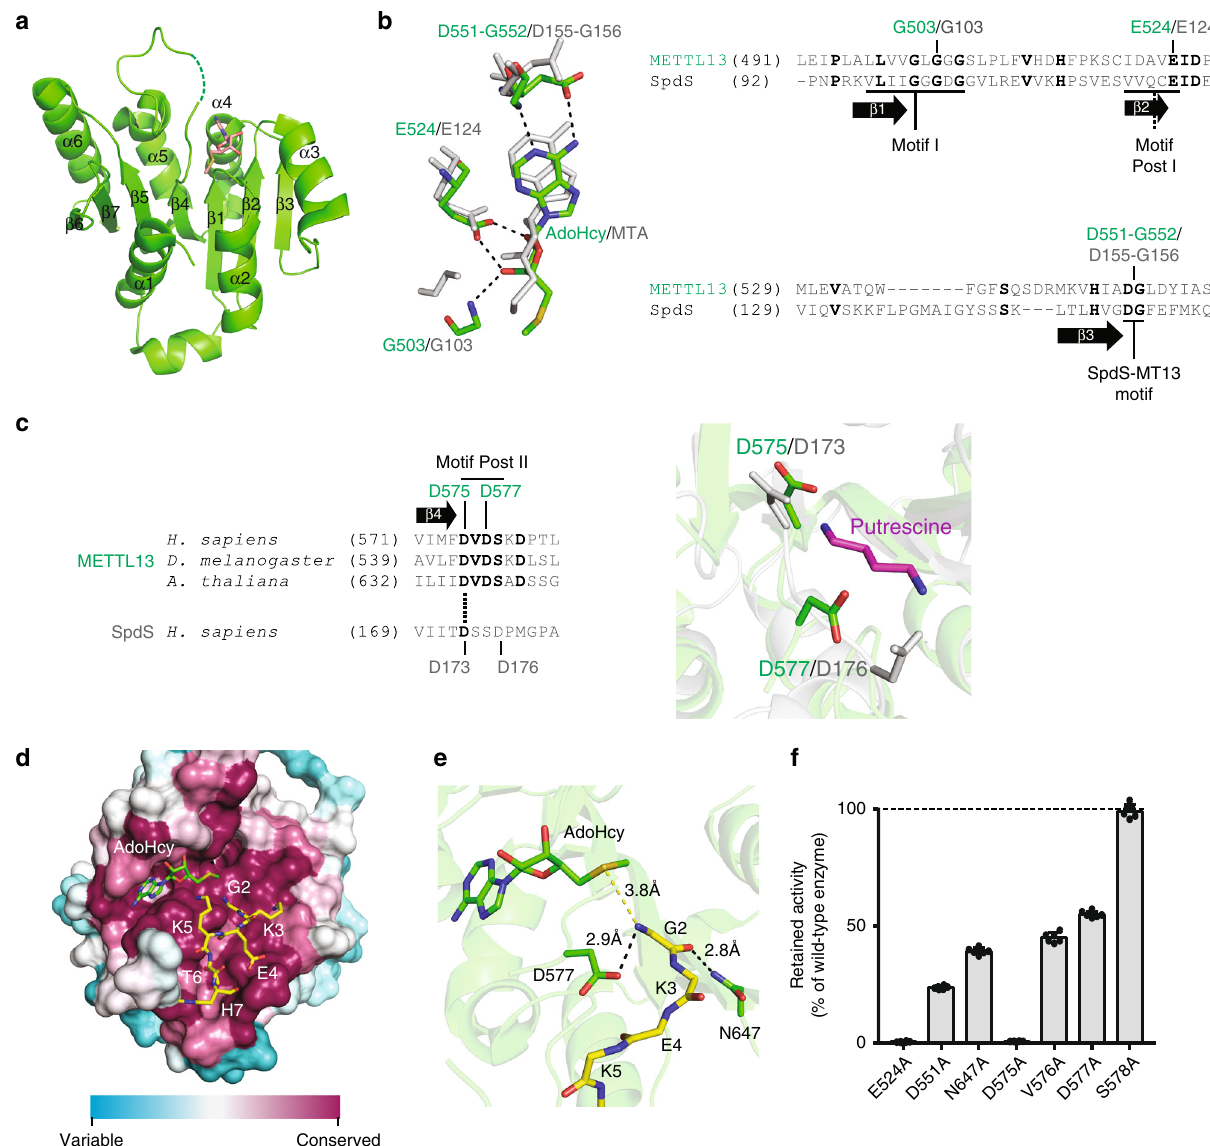
Fig. 4 Structural analysis of MT13-C. a Crystal structure of the core MTase domain of MT13-C in complex with AdoHcy. The 7BS fold is shown in ribbon representation in green with AdoHcy shown in stick model in salmon. Unresolved density for the backbone of Lys578 is indicated by a dashed line. b Key AdoHcy binding residues in MT13-C and comparison with SpdS (PDB code 2o06). AdoHcy and the residues involved in its coordination in the MT13-C structure are shown in stick representation in green, whereas corresponding residues and the MTA cofactor in the SpdS structure are shown in gray. Sequence alignments illustrate the localization of these residues in key motifs. c Comparison of motif Post II residues between MT13-C and SpdS (PDB code 2o06). In the structural representation, motif Post II residues in MT13-C and SpdS are indicated as stick models in green and gray, respectively. The putrescine substrate of SpdS is indicated in magenta. The sequence alignment indicates the location of the corresponding residues in the respective primary sequences, and illustrates the conservation of motif Post II between METTL13 orthologs. d Surface representation of MT13-C showing sequence conservation. Evolutionary conservation was assessed using ConSurf web server 47 . The cofactor AdoHcy and docked eEFA1 hexapeptide (GKEKTH) are shown as stick models in green and yellow, respectively. e Close-up view of the MT13-C substrate binding site with docked peptide. AdoHcy and MT13-C residues predicted to interact with the N-terminal glycine (G2) are shown as stick model in green. The backbone of the substrate peptide (GKEKTH) is shown as stick model in yellow. f Mutational analysis of key residues in MT13-C. MT13-C protein constructs harboring indicated single amino acid substitutions were evaluated for MTase activity on eEF1A. Activities of mutant enzymes are represented as relative to wild type. Error bars represent s.d., n = MT13-C is a novel type of N-terminal MTase . MT13-C repre- the methylation reaction, representing the demethylated form of AdoMet. Based on its sequence, MT13-C belongs to the family of sents a new type of N-terminal MTase. To obtain further insights Rossmann fold-like 7BS MTases, and, correspondingly, the into its molecular mechanism, we determined the crystal struc- determined structure of the MT13-C MTase domain reveals a ture of its core MTase domain (residues 470 – 699) (Fig. 4a, classic 7BS structure, consisting of a twisted 7BS sheet surrounded Supplementary Fig. 7 and Supplementary Table 1) in complex by six α -helices, three on each side (Fig. 4a). The closest human with S -adenosylhomocysteine (AdoHcy), which is a byproduct of